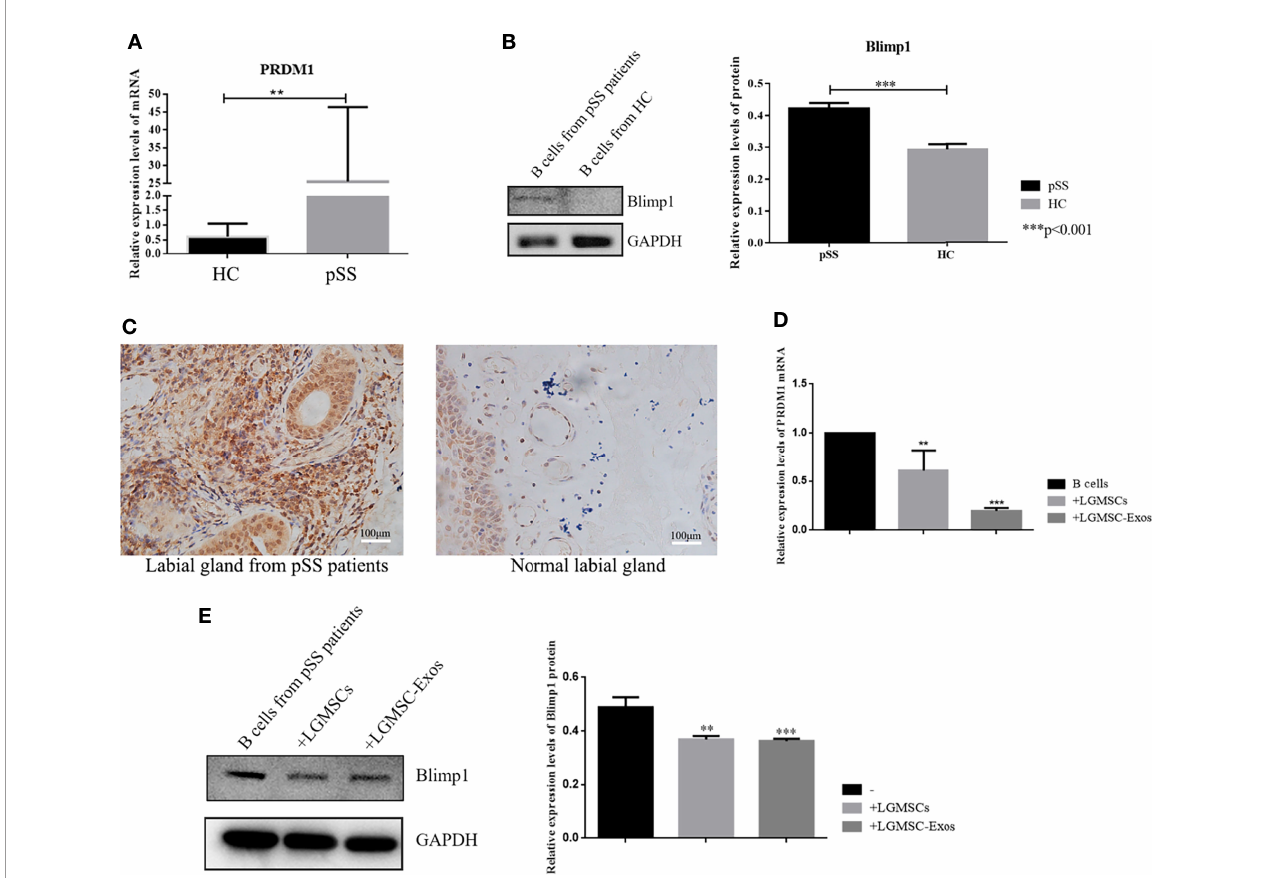
FIGURE 5 | PRDM1 expression is regulated by LGMSC-Exos. (A) Relative mRNA expression levels of PRDM1 in B cells from HCs and patients with pSS. (B) Results of western blotting for PRDM1 in B cells from HCs and patients with pSS. (C) Immunohistochemical staining of PRDM1 in the labial glands from patients with pSS and normal labial glands. (D) Relative mRNA expression levels of PRDM1 after coculture with LGMSCs and LGMSC-Exos. (E) Western blotting analysis of PRDM1 after coculture with LGMSCs and LGMSC-Exos. Data represent the mean ± standard deviation (SD; n = 3 independent experiments). ***p < 0.001, **p <